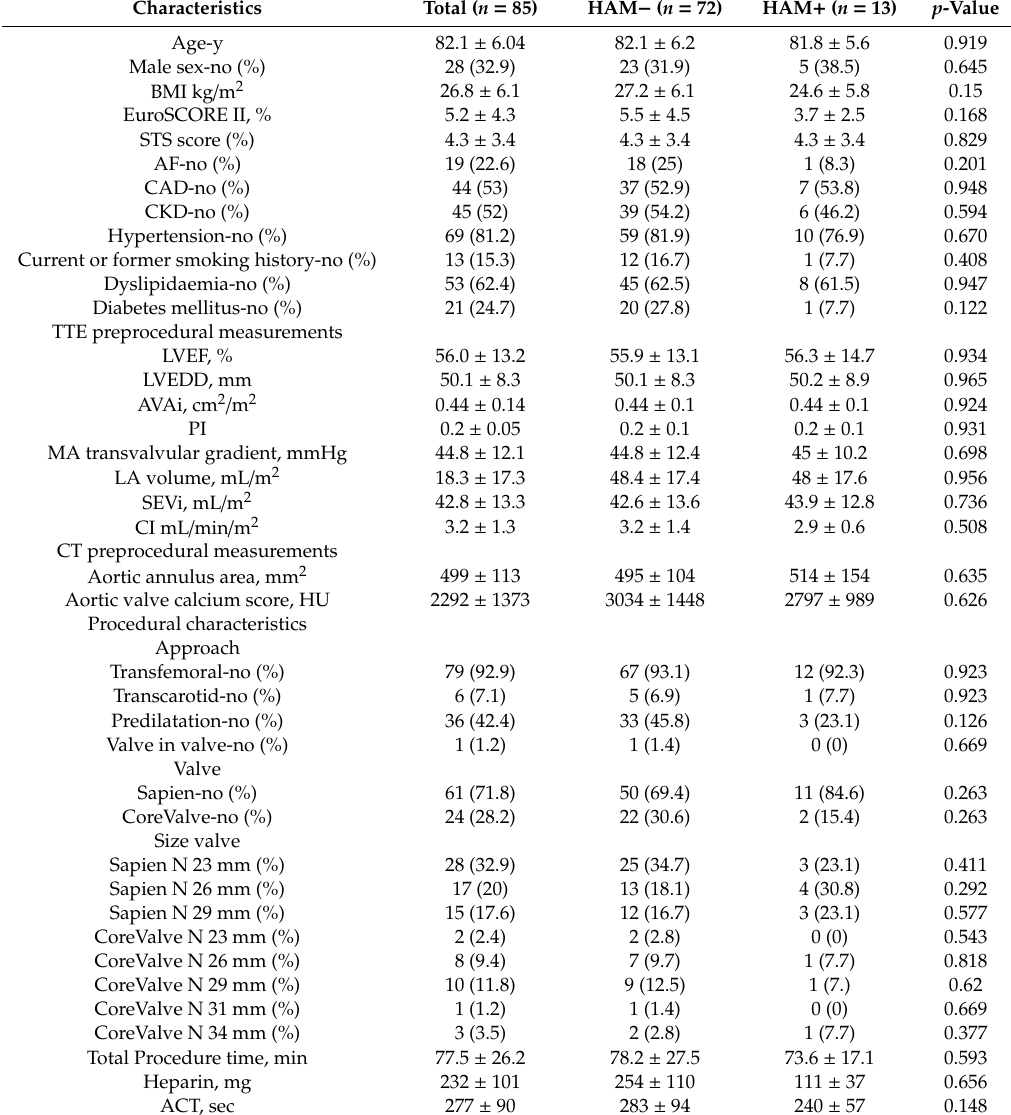
Baseline clinical, echocardiographic, and procedural characteristics according to HAM